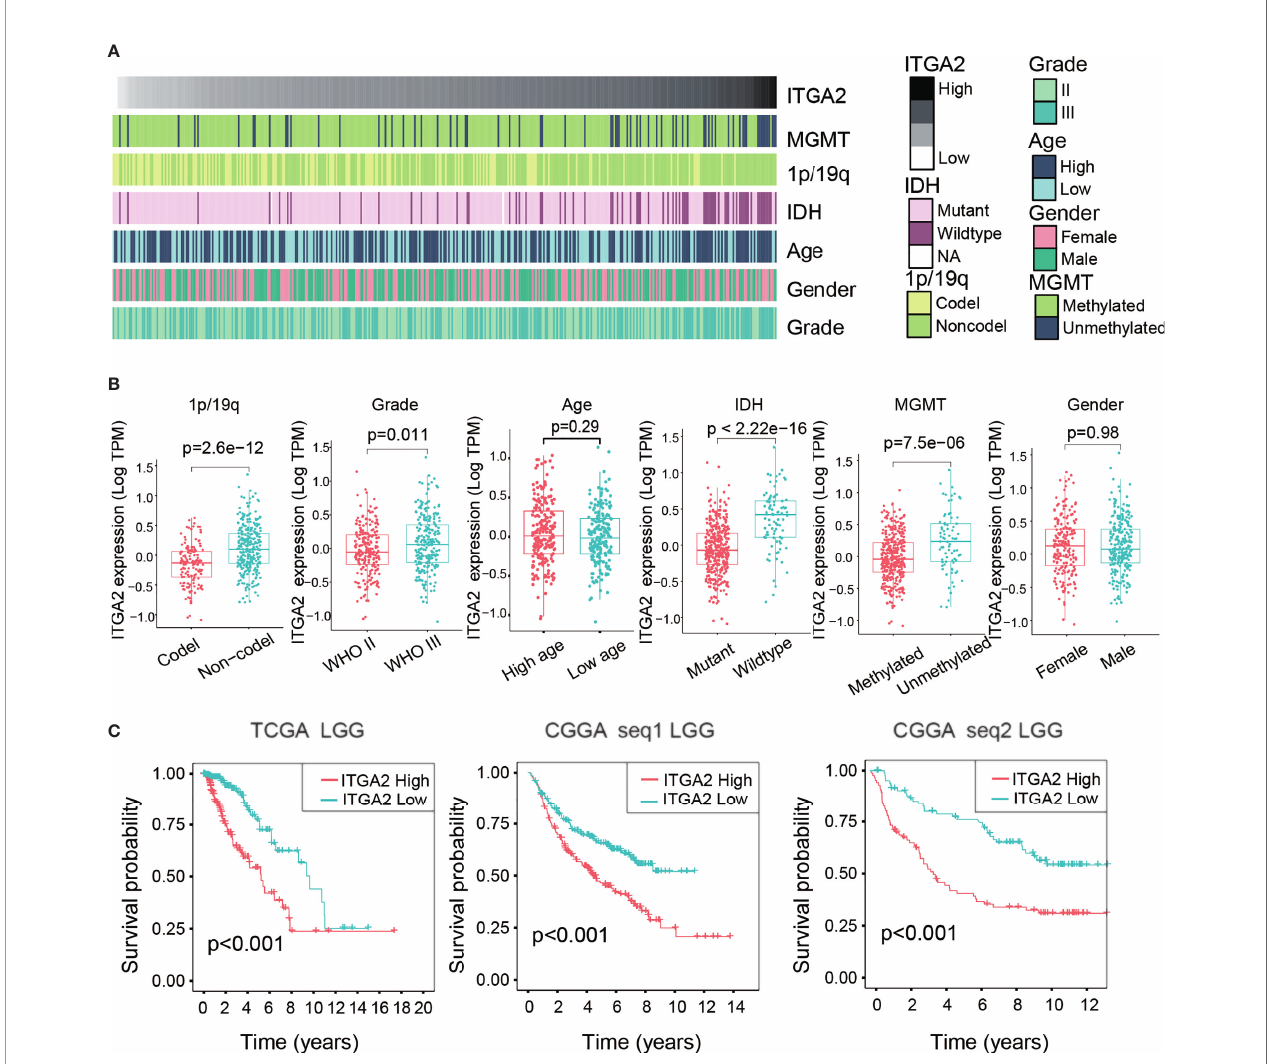
FIGURE 1 | Clinical relevance of integrin alpha-2 (ITGA2) in patients with lower-grade glioma. (A) Relationship between ITGA2 expression pro fi les and clinical features of gliomas. (B) Variance analysis of ITGA2 expression in various clinical traits [gender, age, grade, IDH , 1p/19q, and O(6)-methylguanine-DNA methyltransferase] in The Cancer Genome Atlas (TCGA) cohort. (C) Prognostic analysis of different ITGA2 groups in a cohort from TCGA and two cohorts from the Chinese Glioma Genome Atlas, CGGAseq1 and